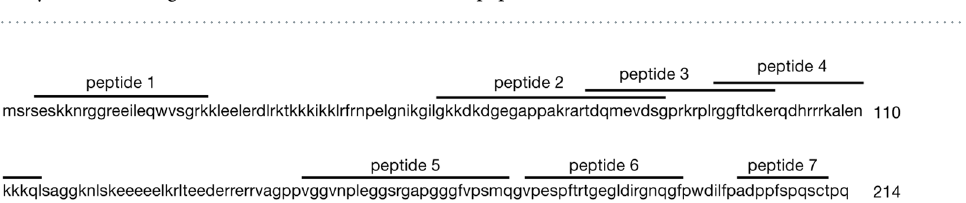
and all 16 HDV RNA positive samples had detectable antibodies resulting in a positive predictive value of 69.6% of the prototype test. Sero-reactivity of the sample set was confirmed with a comparator anti-delta IgG assay; the prototype assay and the commercial ELISA matched detection of all HDV RNA positive samples (Supplemental